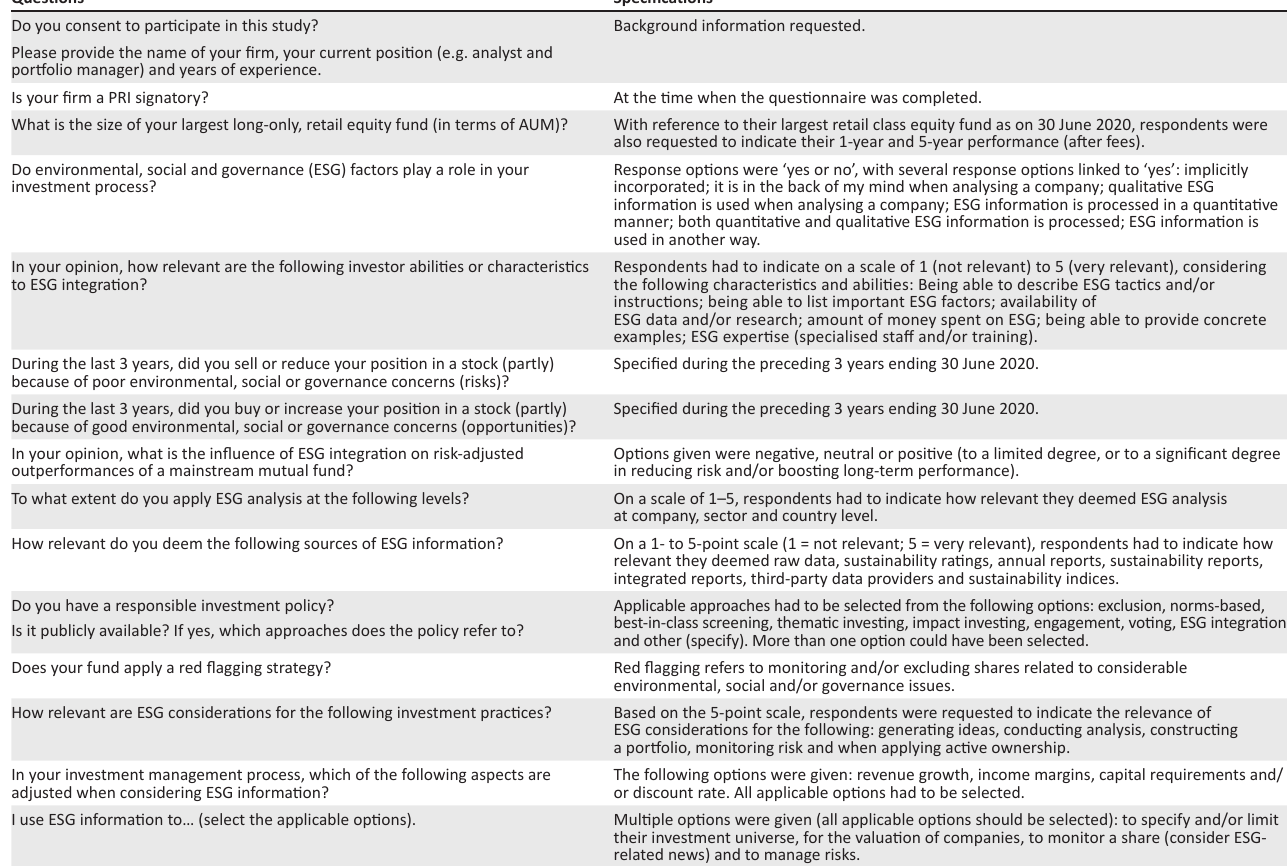
TABLE 1: Summary of the online questionnaire.